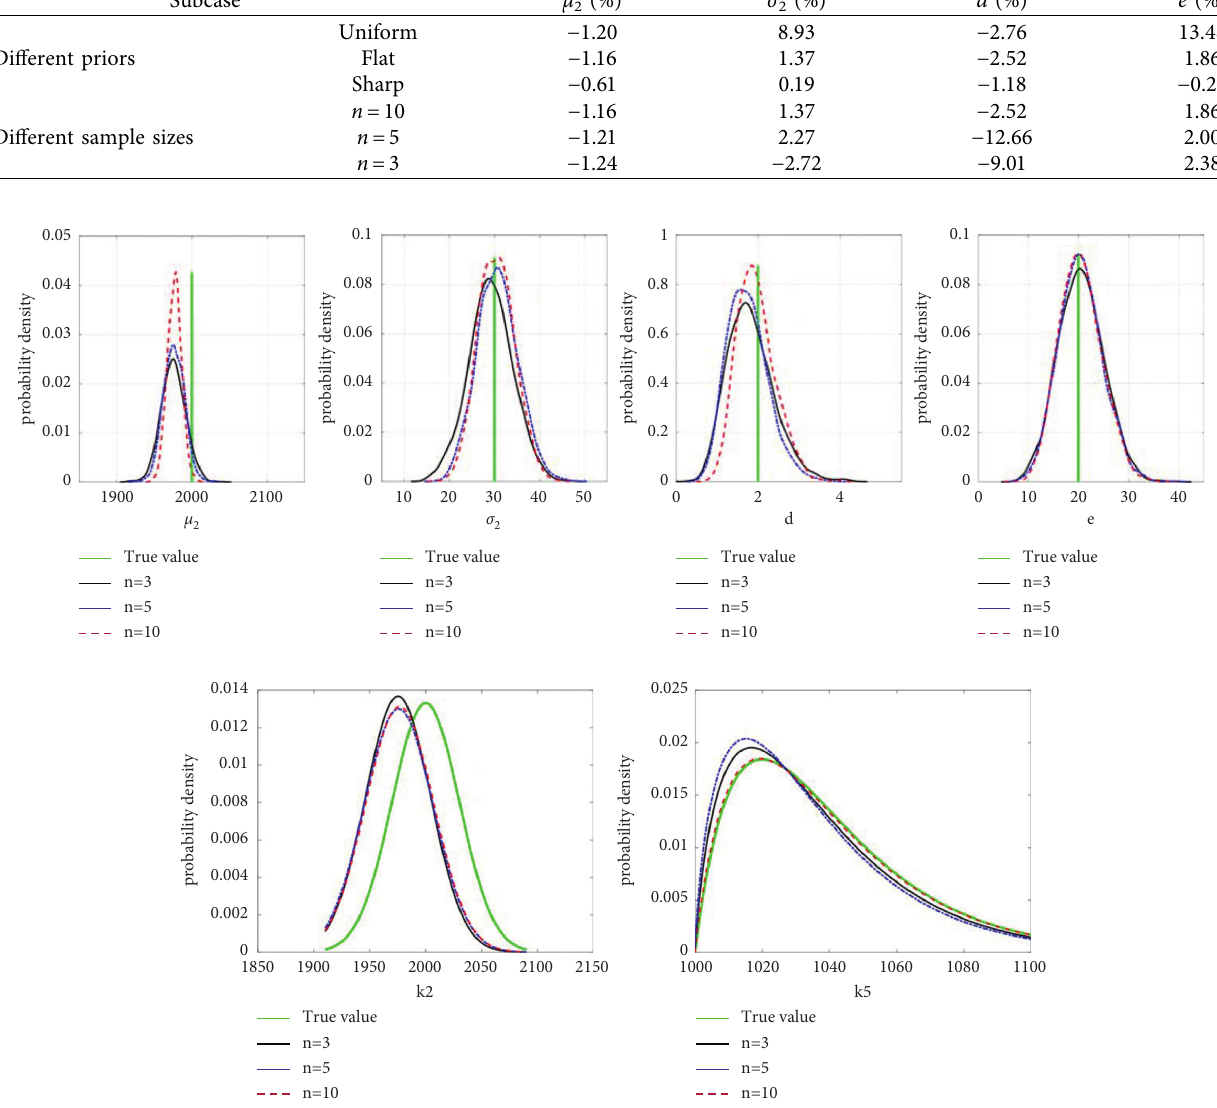
in specified input could also 4